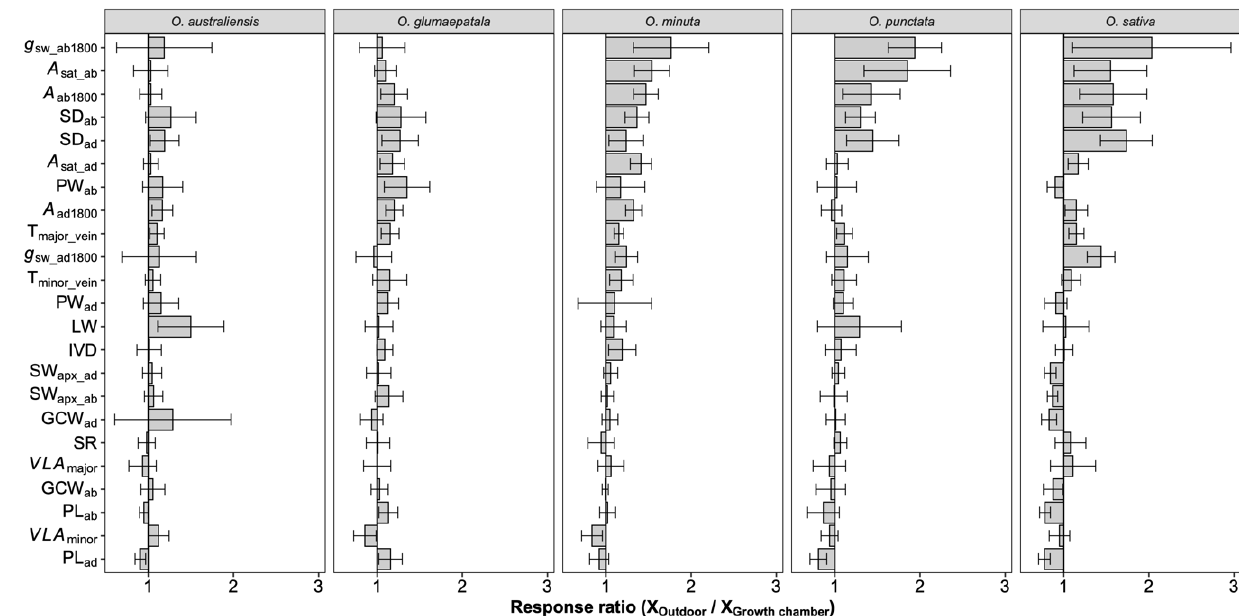
Figure 5. Response ratio of leaf traits to growth environments for each species. Bars denote the response ratios, and the error bars are the 95% confidence intervals (calculations see M&M section). A response ratio smaller than, equal to, and larger than 1 corresponds to a lower, equal, and higher value under outdoor conditions than under growth chamber conditions, respectively. The response ratios statistically differed from 1 if their confidence intervals did not cover 1. See Table 1 for definitions of the variables. n = 5 individual plants.